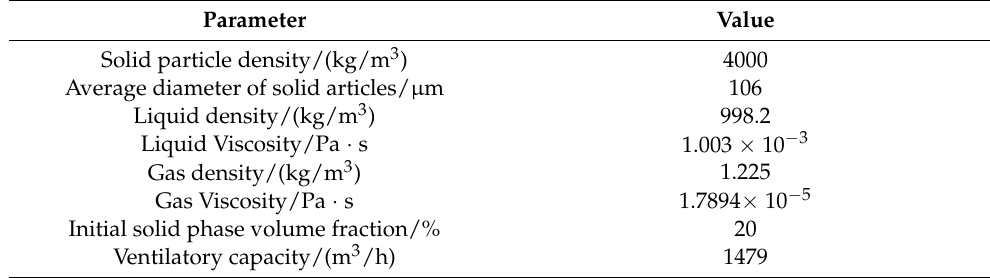
Table 3. Three-phase physical